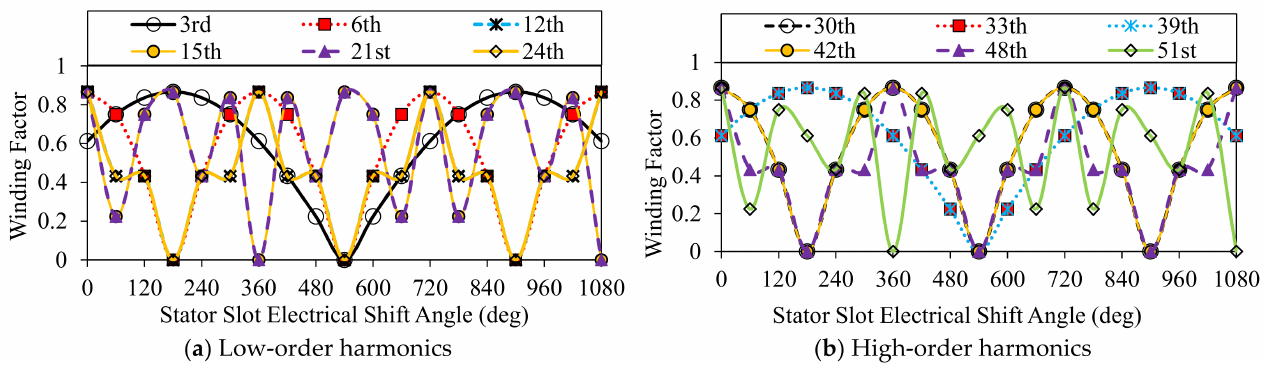
Figure 6. Variation of low-order ( a ) and high-order ( b ) harmonics with respect to shift angle α while the winding set polarizations are ( + , + ).